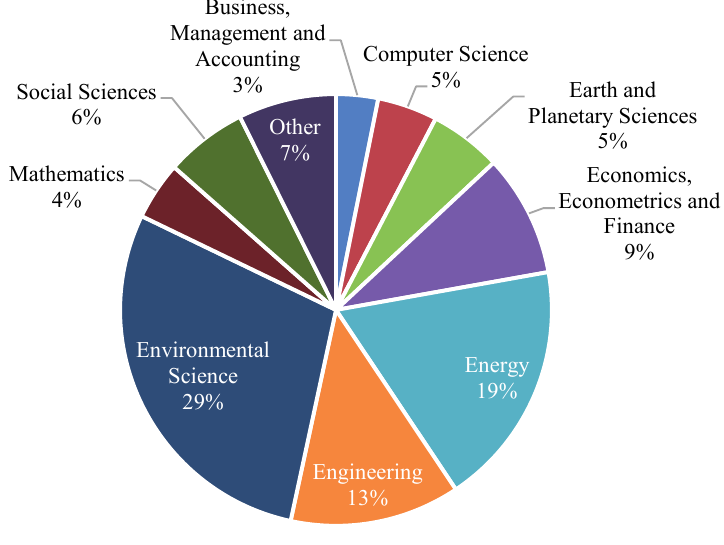
Fig. 3. Overall trend in the subject area of publications for all